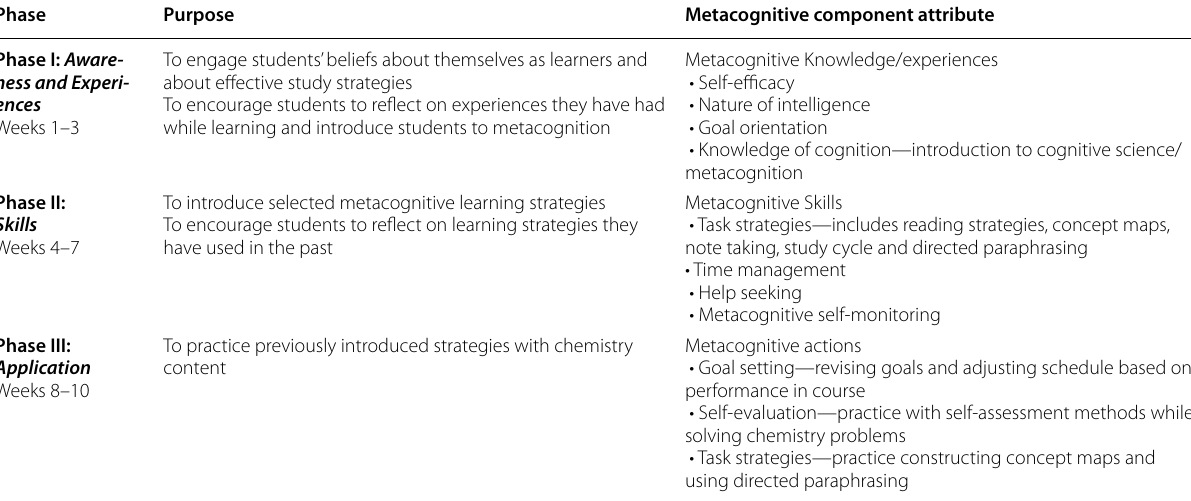
The framework presented here incorporates each of Flavell’s components (right column) into three phases (left column)—Awareness and Experiences, Skills, and Application. Selected attributes identified by the authors are placed into each of these three phases